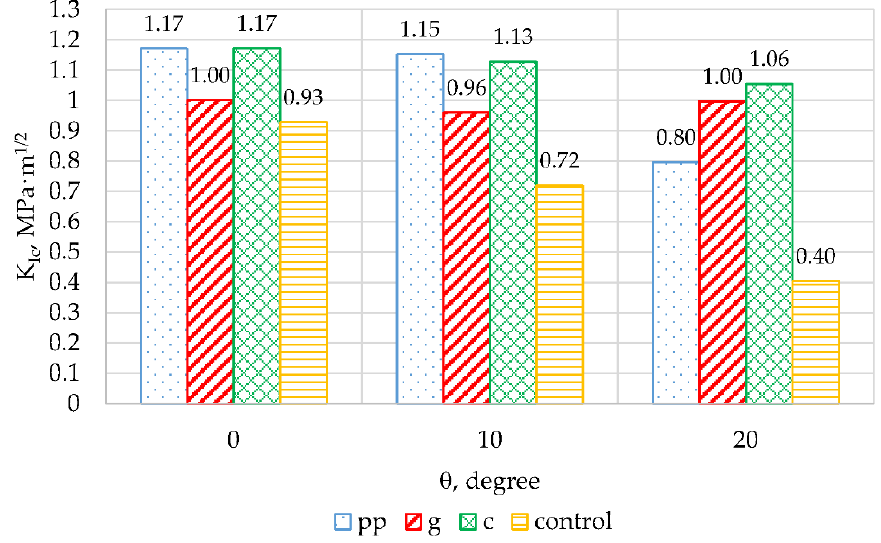
Figure 17. K IC for all types of mortars for different crack inclination angles.